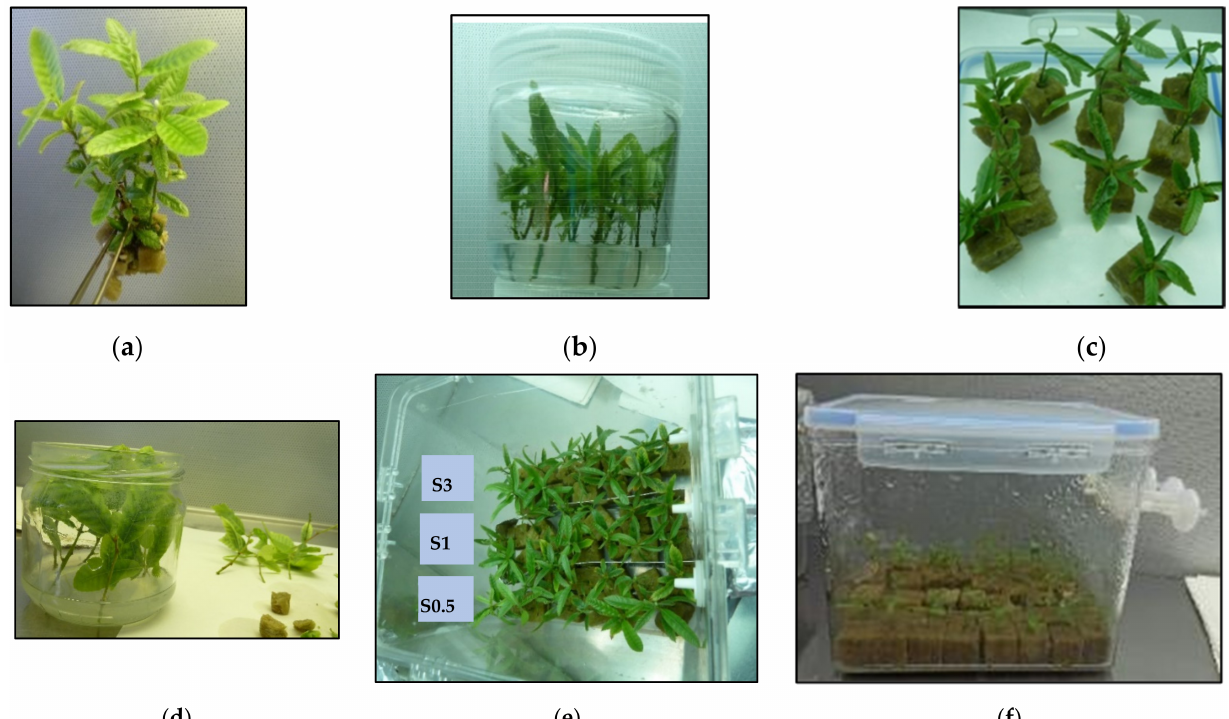
Figure 9. Rooting of chestnut shoots from clones CO53 and PO42. ( a ) Shoots of CO53 cultured in S3% selected for rooting. ( b , c ) Shoots of CO53 cultured in S1% during root induction ( b ) and inserted in rockwool cubes. ( c , d ) Shoots of PO42 cultured in S1% during root induction. ( e , f ) Shoots of CO53 cultured in S1% and transferred to medium with S0.5, 1 and 3% 24 h after root